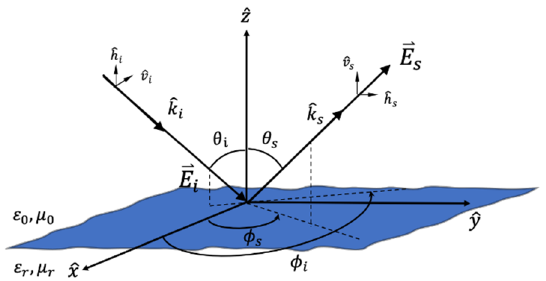
Figure 1. Geometry of the bistatic scattering from a sea surface.